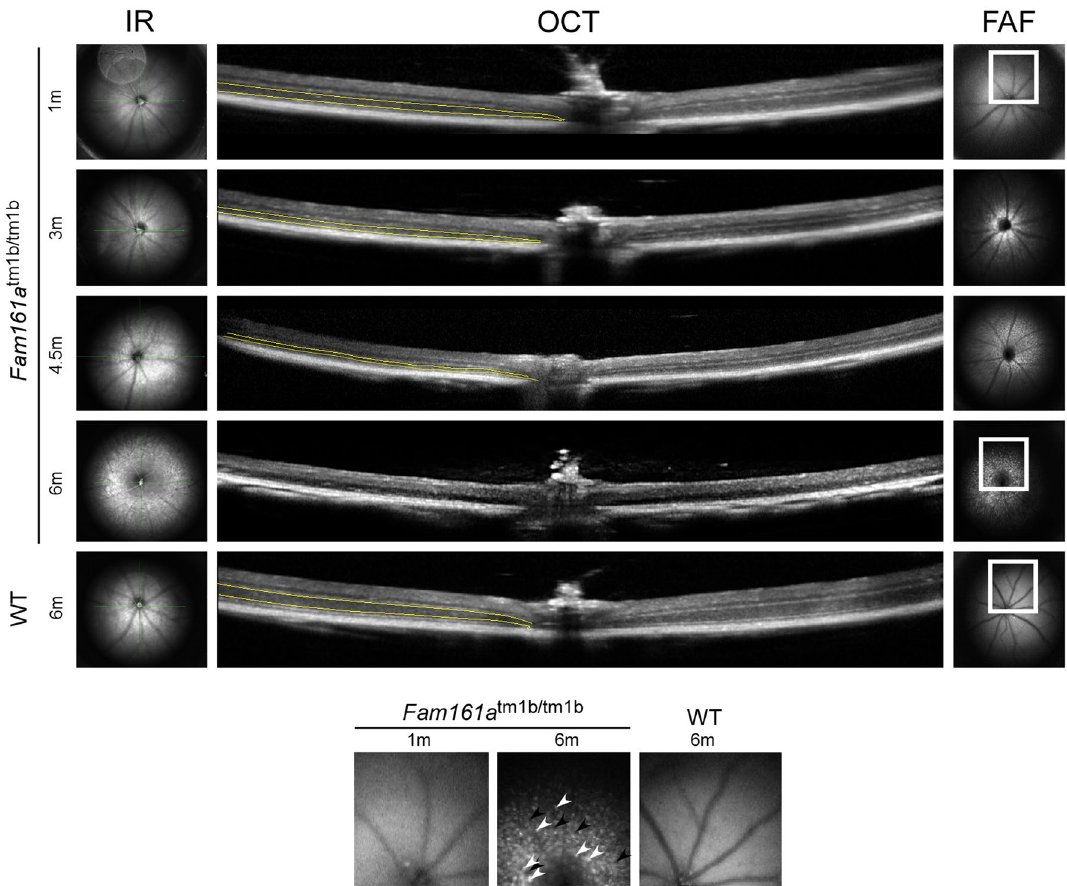
Figure 4. FAF and OCT imaging of Fam161a tm1b/tm1b mouse retinas at different ages. A comparison between Fam161a tm1b/tm1b mouse retinas at 1, 3, 4.5 and 6 months of age and WT mouse retina at the age of 6 months is presented. The outer nuclear layer which represents the photoreceptors is marked by yellow lines. Enlarged areas are highlighted in squares and are shown at the bottom of the figure. Patchy hypoautofluorescent spots are marked with black arrowheads and hyperautofluorescent spots are marked with white